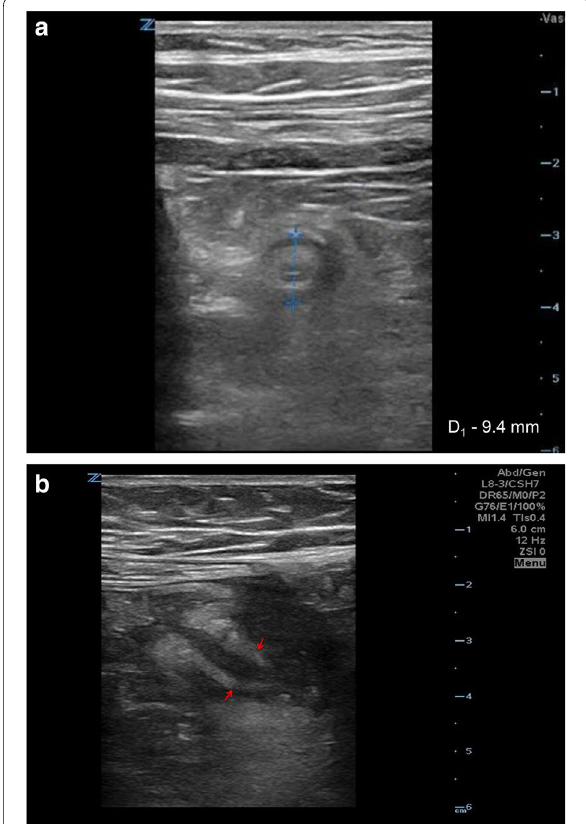
Fig. 1 a Transverse (short axis) ultrasound scan shows SA measuring 9.4 mm in diameter. b Longitudinal ultrasound scan shows tubular blind-ended structure with surrounding with free